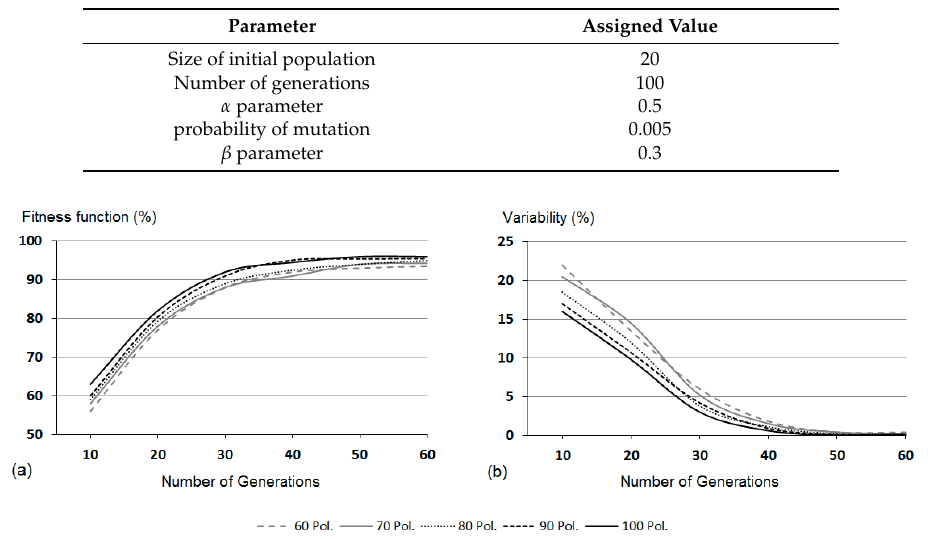
Figure 7. RCGA convergence with different initial populations.